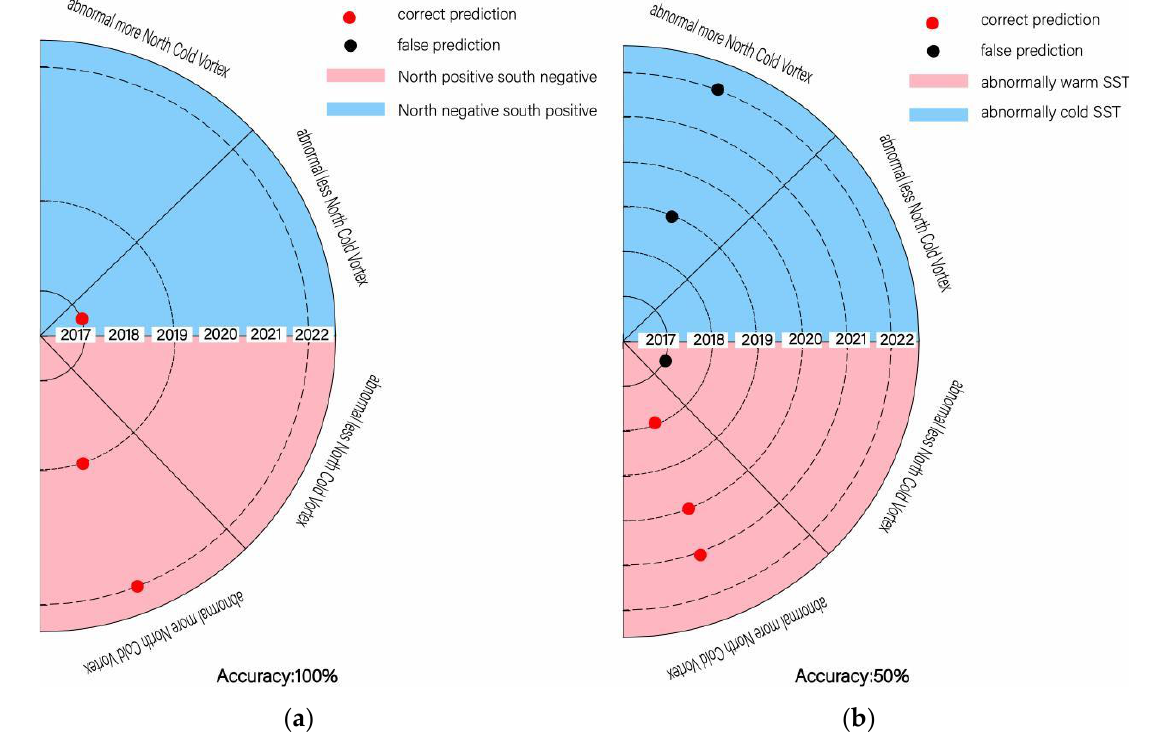
Figure 8. Forecast accuracy of northern NCV using the ( a ) northwest Pacific north – south anti-phase SST and ( b ) southeast Pacific SST.